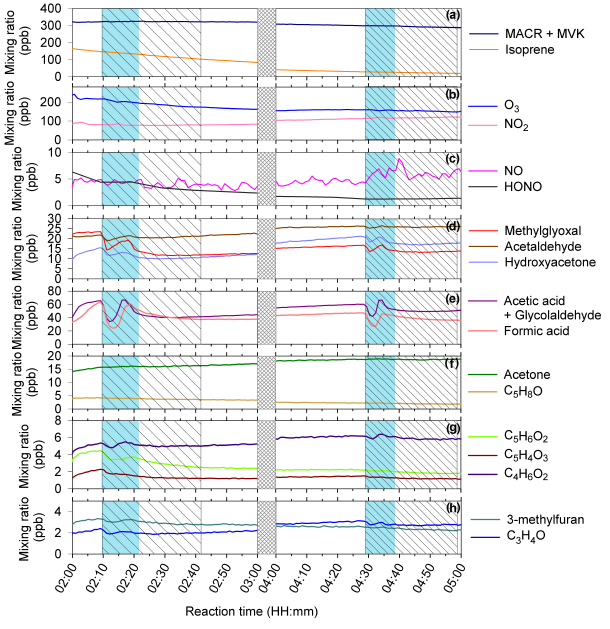
Figure 2. Time profiles of the gas phase reactants and isoprene ox- idation products during a diphasic experiment (D300113). Blue ar- eas indicate cloud events and hatched area indicate time needed for the PTR-ToF-MS signal to stabilize after the start of cloud genera- tion (droplet and memory effects in the sampling